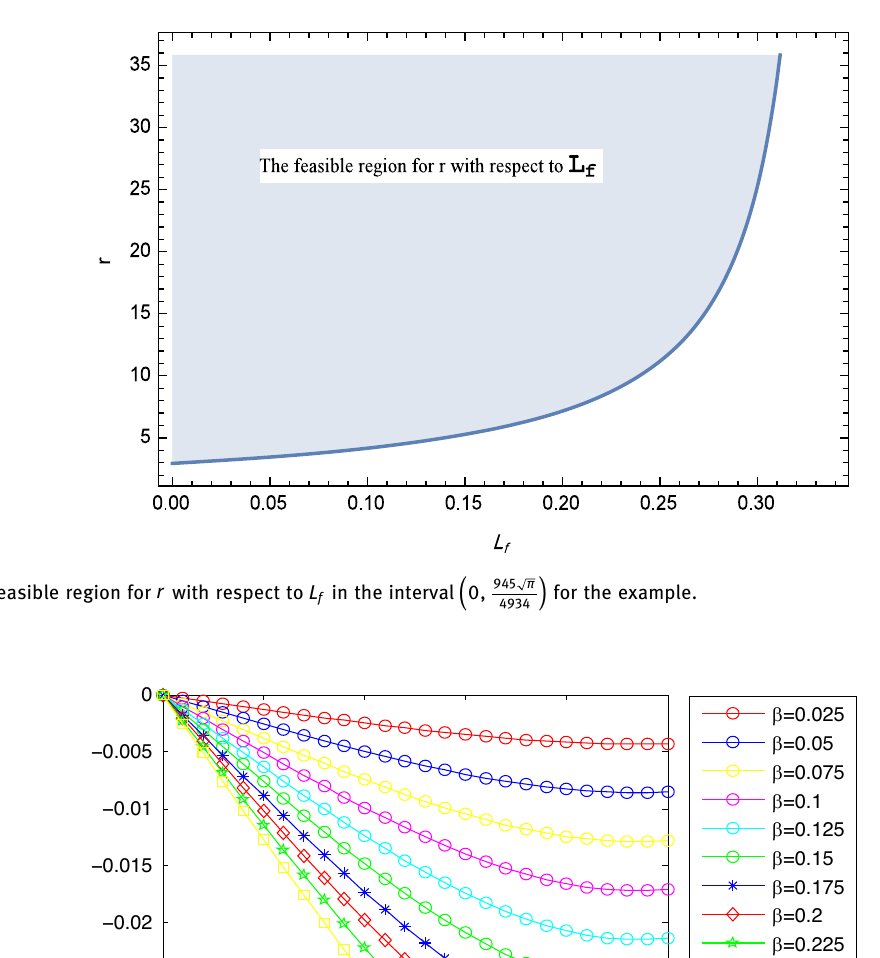
Figure 2: The diagram of numerical solution for di ff erent β values for Example 6.1.